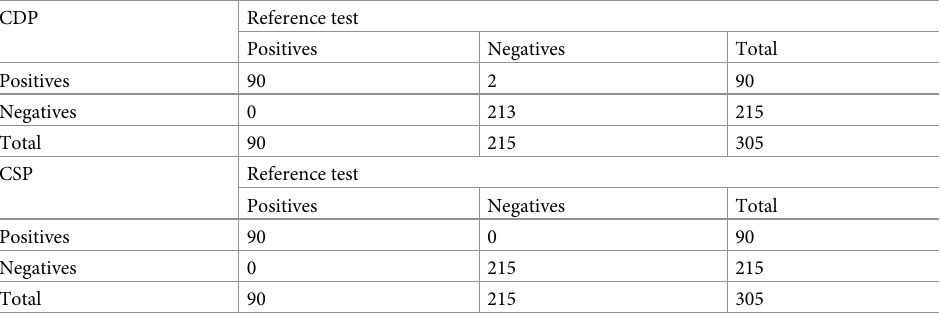
Table 3. Two by two table for the results of the RDT and conventional serological tests for diagnosis of